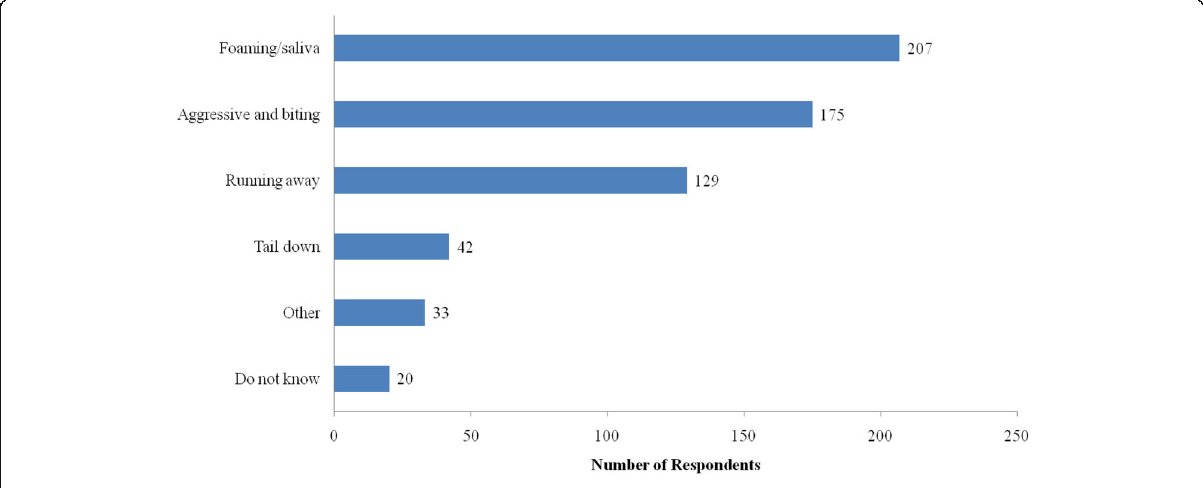
Fig. 3 Clinical signs of rabid dogs known by respondents ( n = 313)